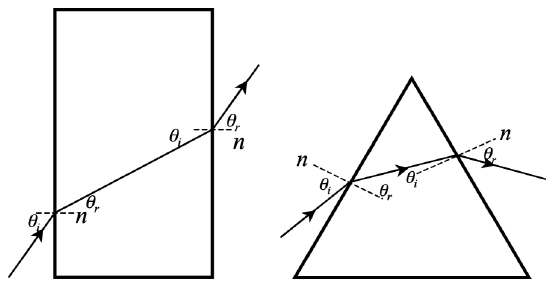
FIG. 2. Rectangle and triangle training examples for experi- ment 2. Note that the triangle example was modified from experiment 1 for reasons that are explained later in the